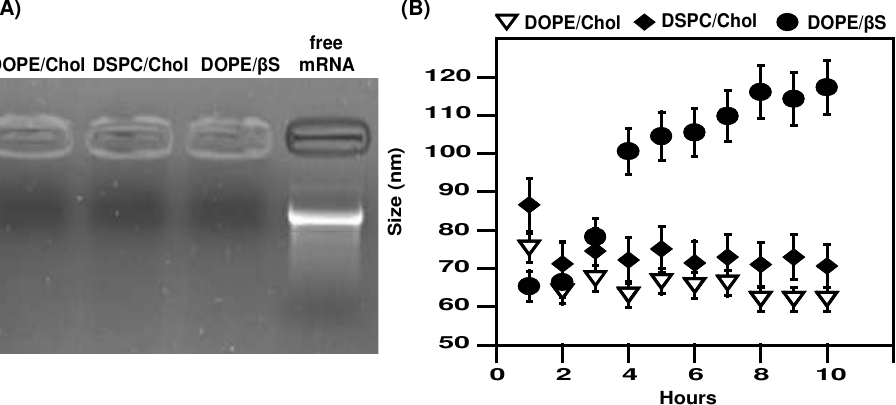
Figure 1. mRNA complexation and stability of mRNA LNPs in serum-containing media. ( A ), mRNA complexation: Free or LNP-complexed mRNA were run on an agarose gel electrophoresis; ( B ), Size stability: LNPs were incubated in media containing bovine serum at 37 °C and size was monitored by DLS. DLS measurements are the mean of two experiments.